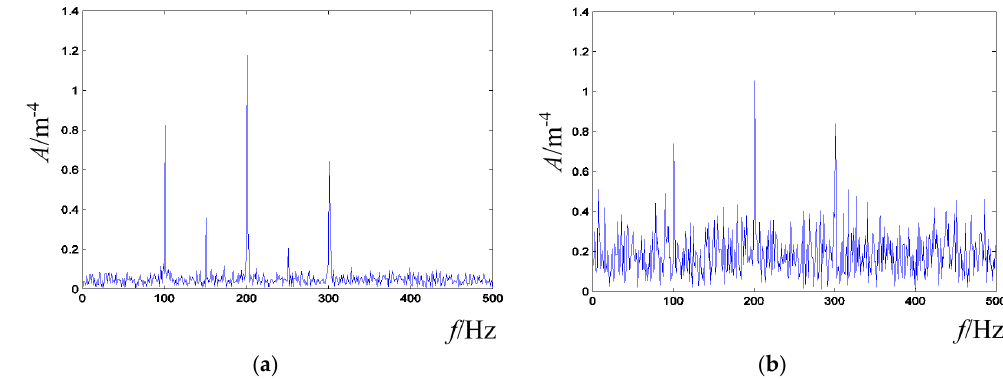
Figure 4. Illustration of the unacceptable case that may occur if the frequency node error is alone taken as the error criterion. ( a ) Destination signal; ( b ) Vibration signal.